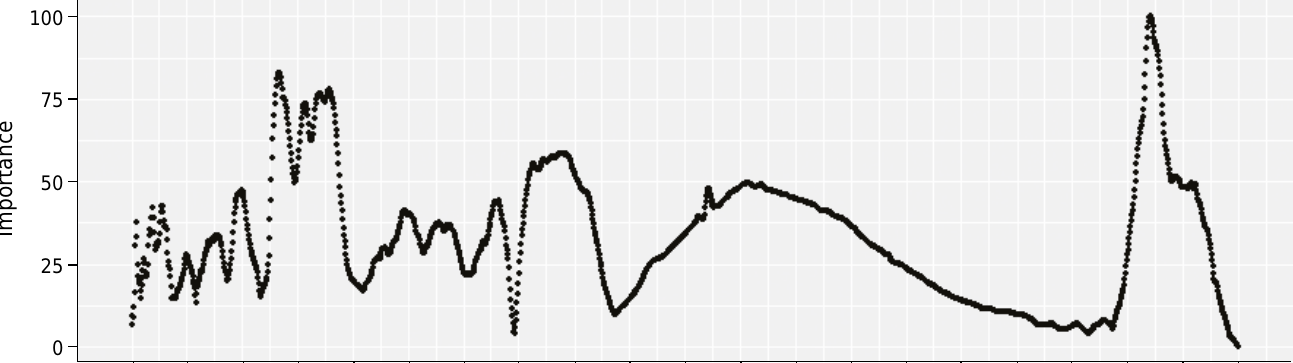
Figure 2. Important variables for prediction of organic carbon in the MIR (Medium Infrared) spectrum using Continuous Removal (CR), Preprocessing, and the Partial Least Squares Regression (PLSR)